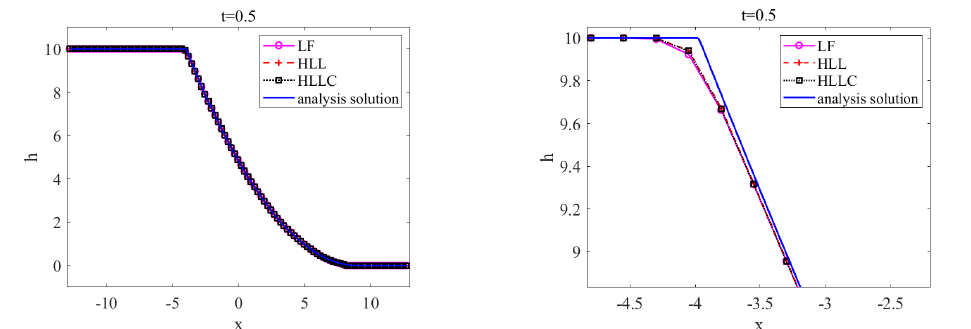
Figure 7. Analytical solution and numerical solutions with WENO–LF, WENO–HLL, and WENO– HLLC along y = 0 for the 2D dam break problem at t = 0.5. The solutions of h on the whole domain ( left ); the solutions of h on the range x ∈ [ − 4.5, − 3 ] ( right ).